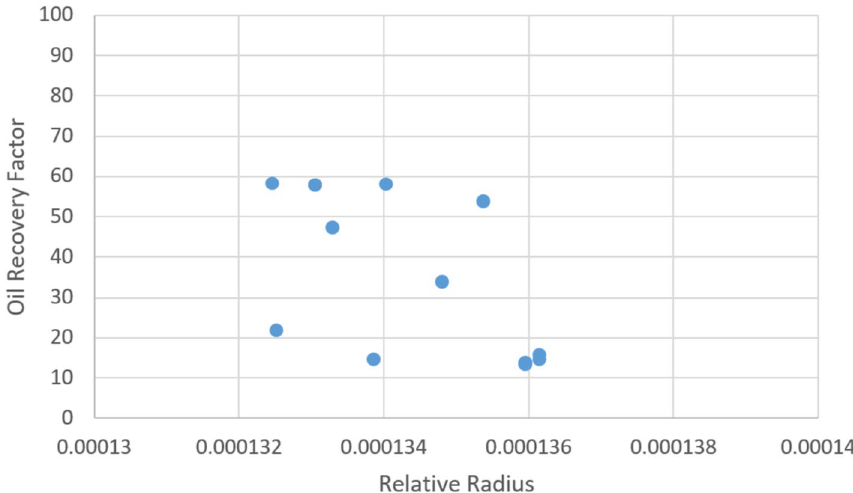
Fig. 3 Relative radius values for high-quality category of porous media